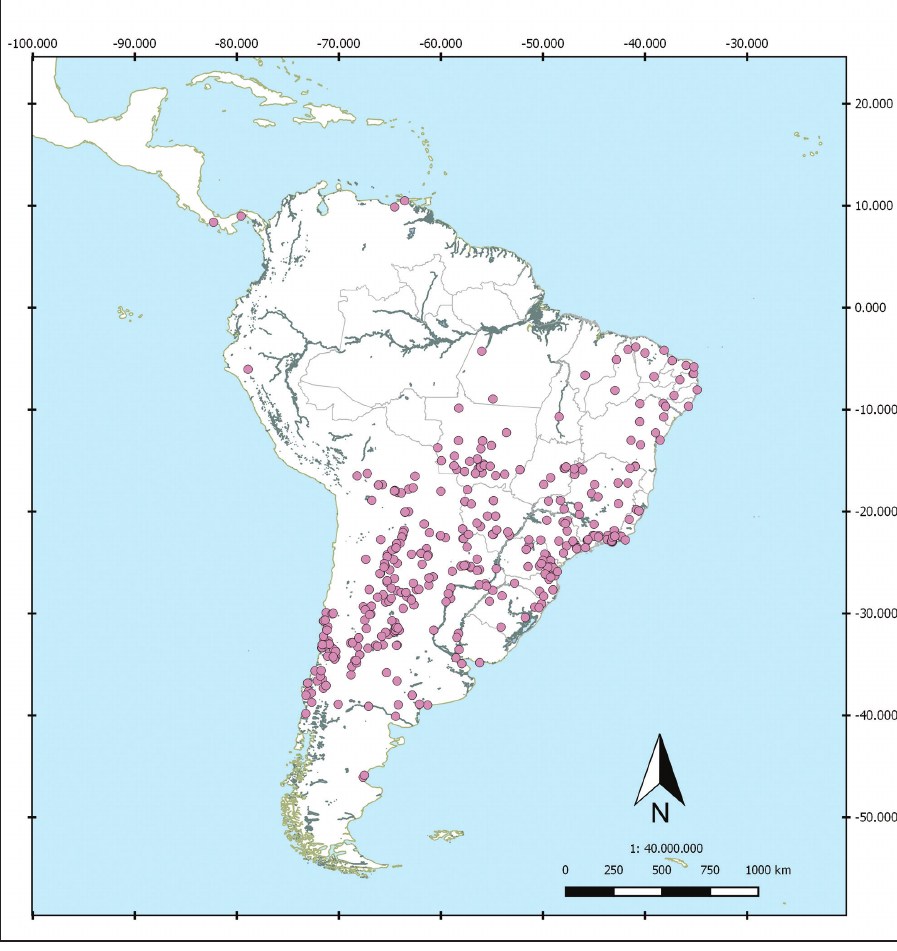
leg., 1 ex. (SDEI); without date, Exp.Dep. Zool. col., Hüsing Halle leg., PARATYPE Liogenys palmata Burm, 1855 G.Frey 1967/68 det., 1 ex. (MHLU); without date and collector, Liogenys testaceipennis Moser Frey 1968 det., 1 ex. (NMHB); 5/XI/1920, J. F. Zikan col., 1 ex.; 14/XI/1919, J. F. Zikan col., 1 ex. (CEIOC). Diagnosis. Body brownish; elongate; elytra testaceous to brownish, pronotum reddish or dark brown; clypeal emargination rounded, shallow and wide; outer sides of anterior teeth sub-parallel; canthus exceeding the outer margin of the eye; male mesotibia quadrate in cross section; male metafemur strongly produced medially on posterior margin; metatibia slightly bent outwards; inner margin of male metatibia medially produced towards apex; claw bifid, symmetrical, superior tooth as long as and narrower than the inferior; male ventrites I, II and III sulcated medially, IV